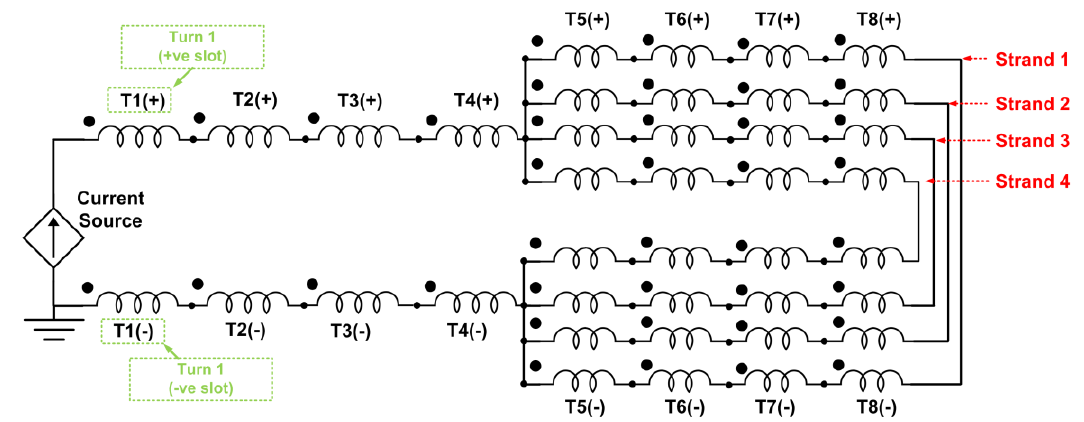
Figure 4. Electrical circuit for the individual conductors in the semi-stranded coil.